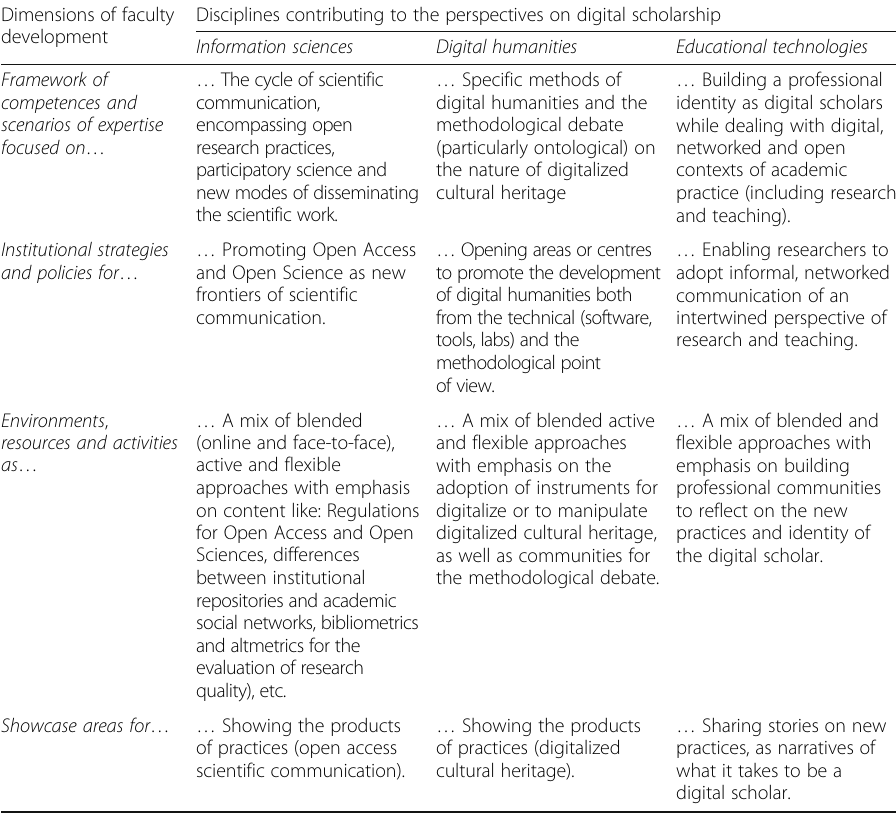
Table 1 Scenarios of faculty development for digital